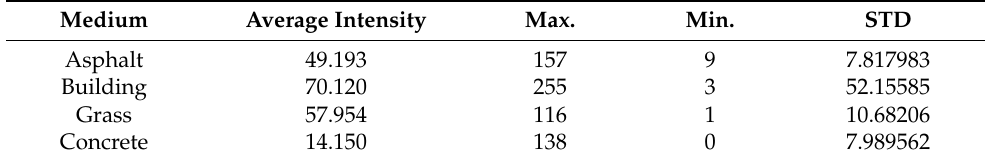
Table 2. Statistics of intensity